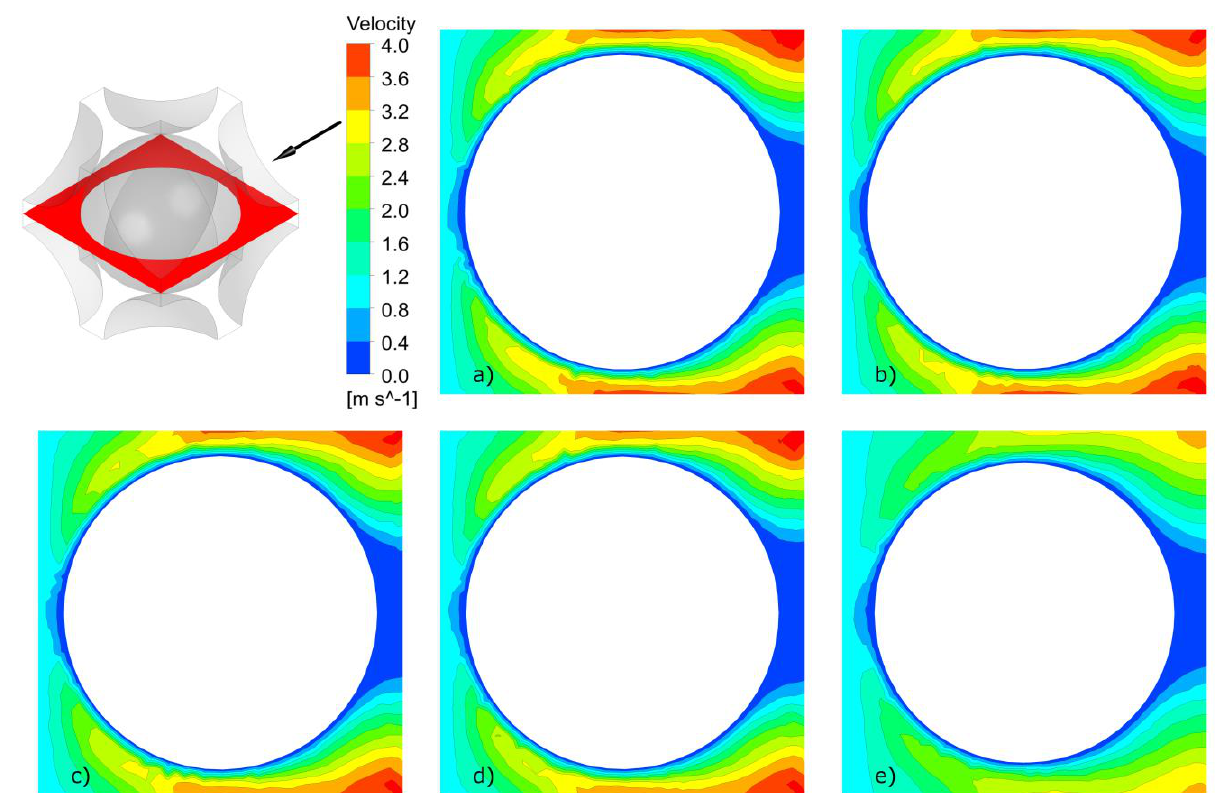
Fig. 12. Velocity magnitude on XZ plane obtained with the discretization method of granule radius reduction R g% equal: